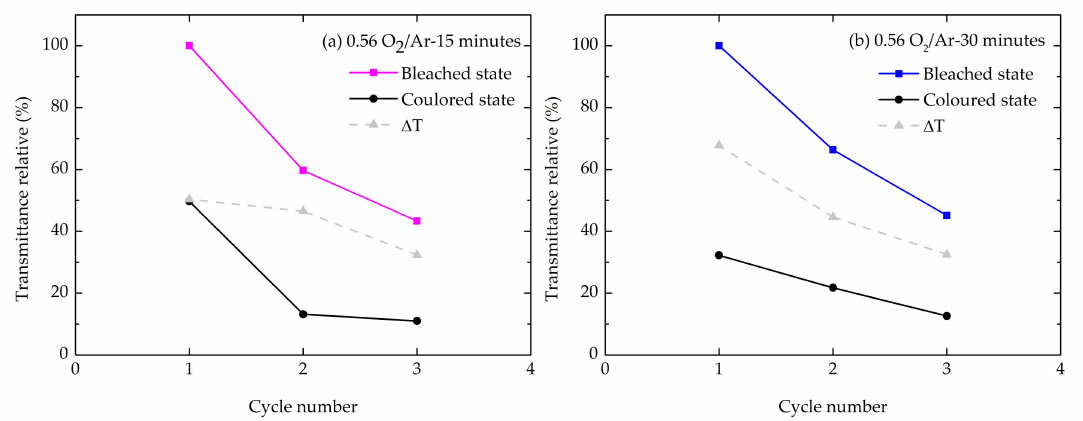
Figure 12. Evolution of representative transmittance of the sample ( a ) 0.56 O 2 /Ar-15 min and ( b ) 0.56 O 2 /Ar-30 min scanned at a rate of 10 mV/s. ∆ T represents the relative optical transmittance difference between the colored and bleached